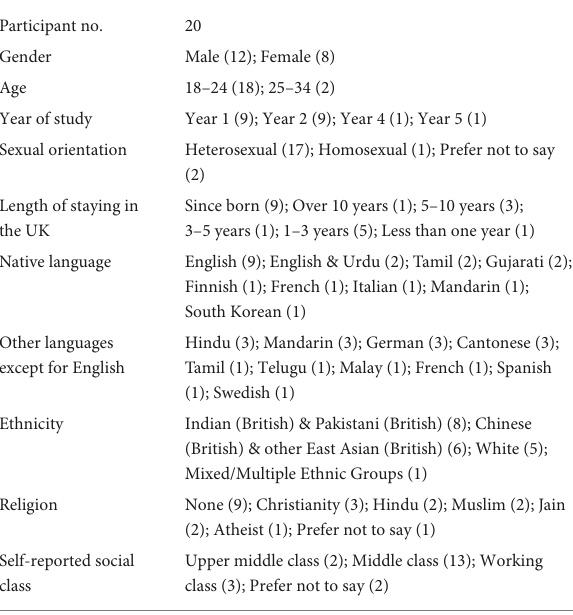
TABLE 3 Demographic information of focus group participants ( n =